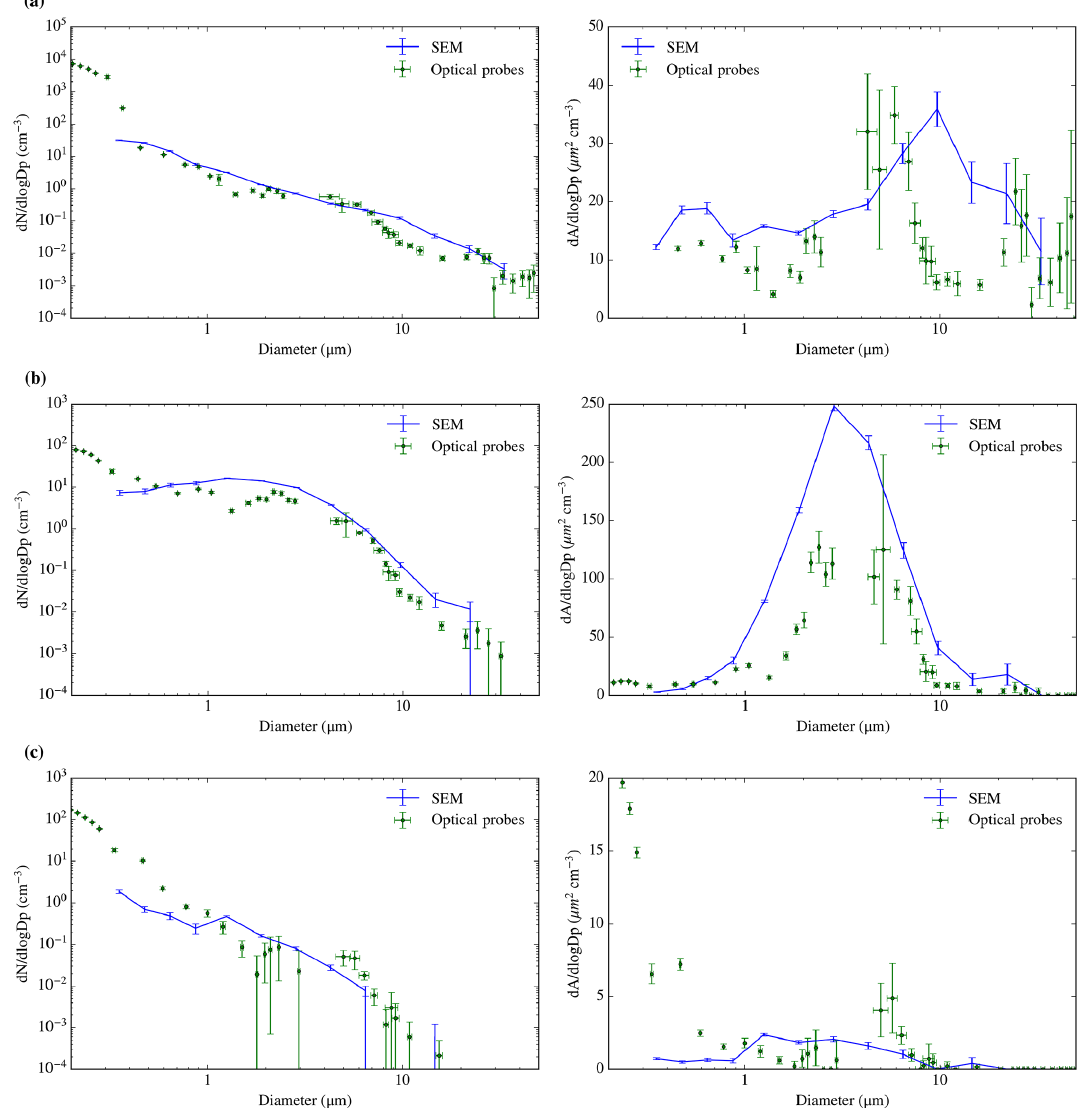
Figure 9. SEM-obtained size distribution compared with PCASP–CDP online size distribution for three different sampling periods in three different aerosol environments. Close to London, on 19 July 2017 (flight C024) from 15:20 to 15:51UTC, sampling 953L (a) ; south of Iceland on 2 October 2017 (flight C059) from 16:24 to 16:40UTC, sampling 432L at an altitude of about 320m (b) ; and in northern Alaska on 20 March 2018 (flight C090) from 20:15 to 20:37UTC, sampling 724L (c) . All the sampling was performed in the upper line with the bypass open. The flow rates through the filter holders are 30.9, 30.5, and 42.0Lmin − 1 respectively. The optical probes are the PCASP–CDP, using the closest calibration to the sampling date and a refractive index of 1.56 as stated in Sect.